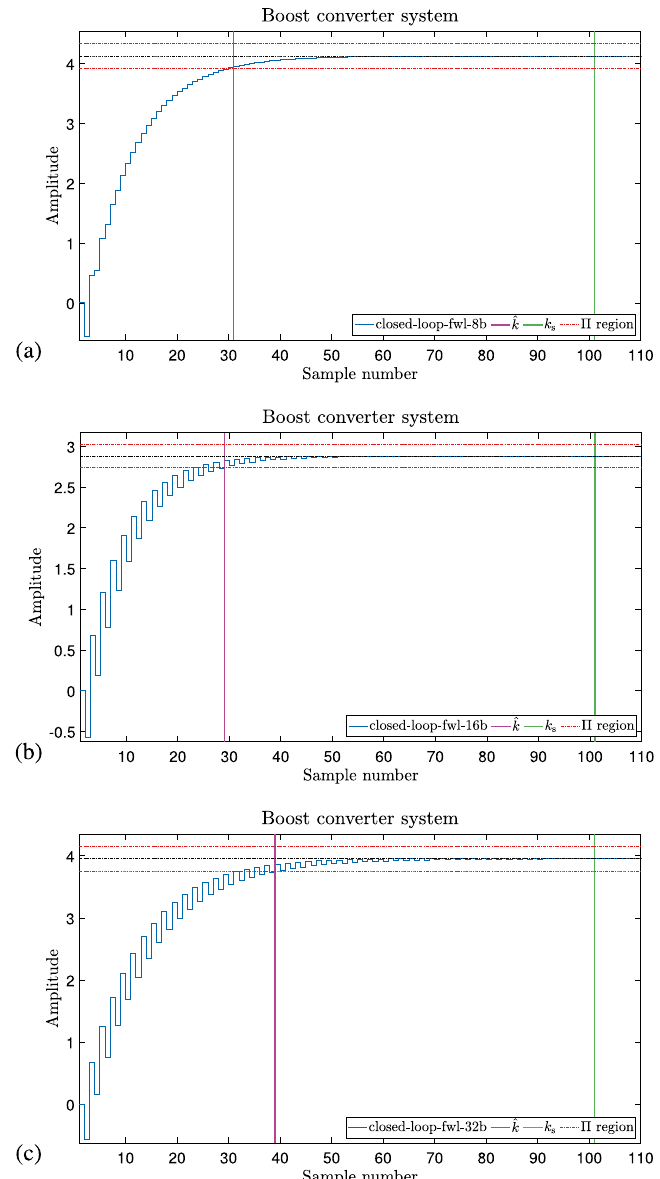
Figure 11. Response output of the boost converter with different FWL effect formats, showing that our controllers meet the requirements. ( a ) FWL (cid:31) 4, 4 (cid:30) ( b ) FWL (cid:31) 8, 8 (cid:30) ( c ) FWL (cid:31) 16, 16 (cid:30)